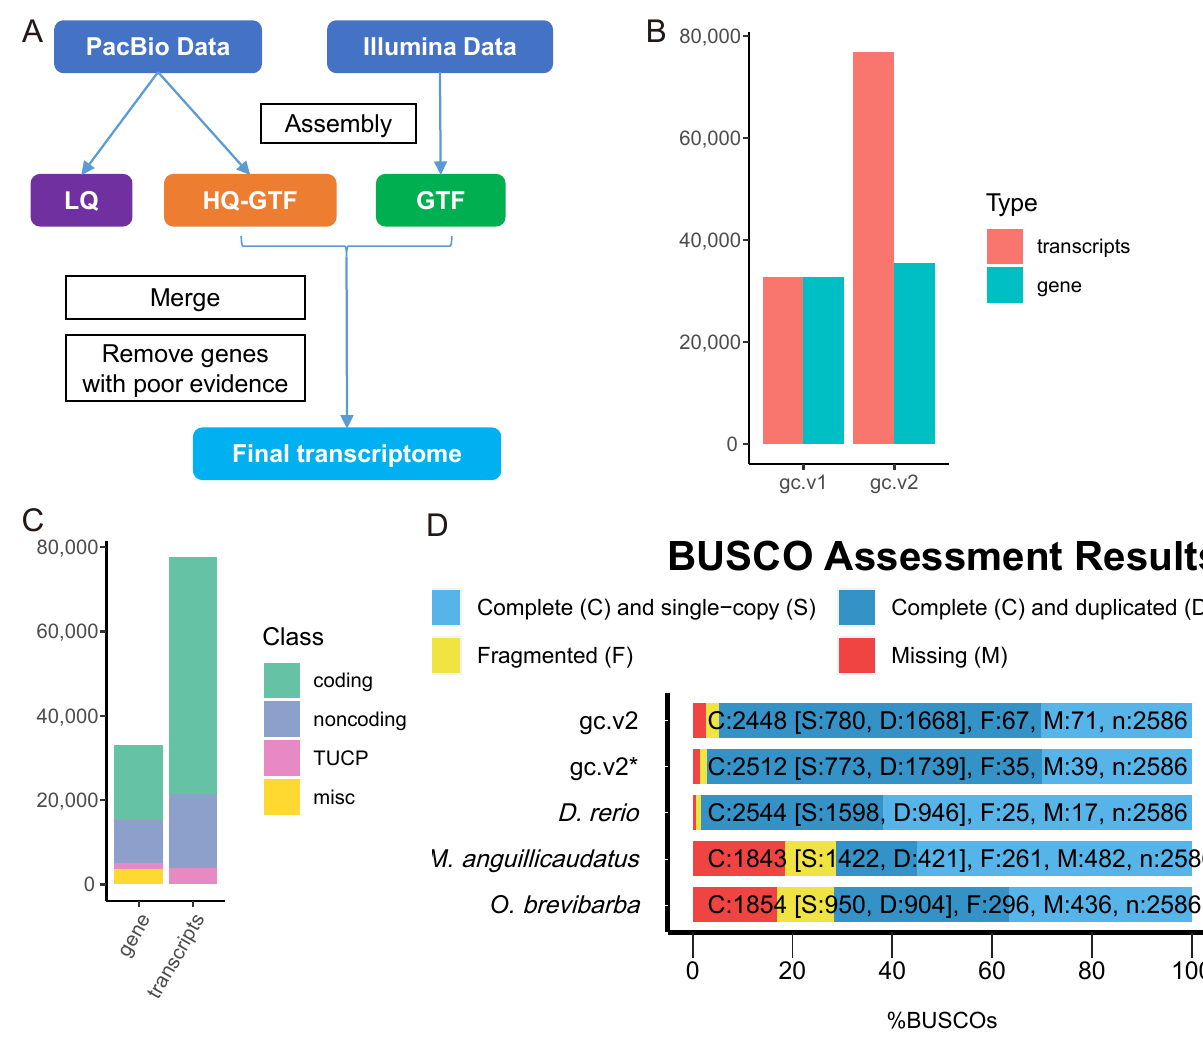
Figure 1. The process of constructing the whole transcriptome of grass carp. ( A ) A schematic representation of the assembly of the transcriptome. ( B ) The gc.v2 genome contains a greater number of transcripts and genes than the gc.v1 genome. The gc.v2 is the transcriptome that was assembled in this study, and the gc.v1 is the annotation information that was found in the draft grass carp genome [54]. ( C ) Statistics on the types of transcripts found in the gc.v2 transcriptome. ( D ) Analysis of the completeness of the gc.v2 transcriptome using BUSCO, which is based on a database of ray- finned fish. The result of calculating gc.v2* was done so under the assumption that all clusters produced by SMRT sequencing are able to generate transcripts based on the grass carp genome. This means that gc.v2* is equal to gc.v2 plus the transcripts that cannot be successfully aligned to the grass carp genome in the SMRT data analysis. D. rerio denotes the zebrafish transcriptome (GRCz11); M. anguillicaudatus represents the loach transcriptome based on SMRT sequencing [28]; O. brevibarba denotes the Onychostoma abrevibarba transcriptome based on SMRT data [36]. Sequences in gc.v2 (3281 bp, median) are much longer than in gc.v1 (1642 bp) and are longer than the sequences both in loach ( Misgurnus anguillicaudatus ) transcriptome (3054) [28] and in Onychostoma brevibarba transcriptome (3054) [29], which were sequenced using SMRT technology. In addition to this, it was significantly longer than the RNAs that were found in the zebrafish transcriptome (2103) (GRCz11) (Supplemental Table S2). The completeness of the gc.v2 transcriptome reaches 93.98 percent, which is better than that of the loach ( Misgurnus anguillicaudatus ) and the Onychostoma brevibarba , which are also based on SMRT sequencing; the only other transcriptome completeness that is lower